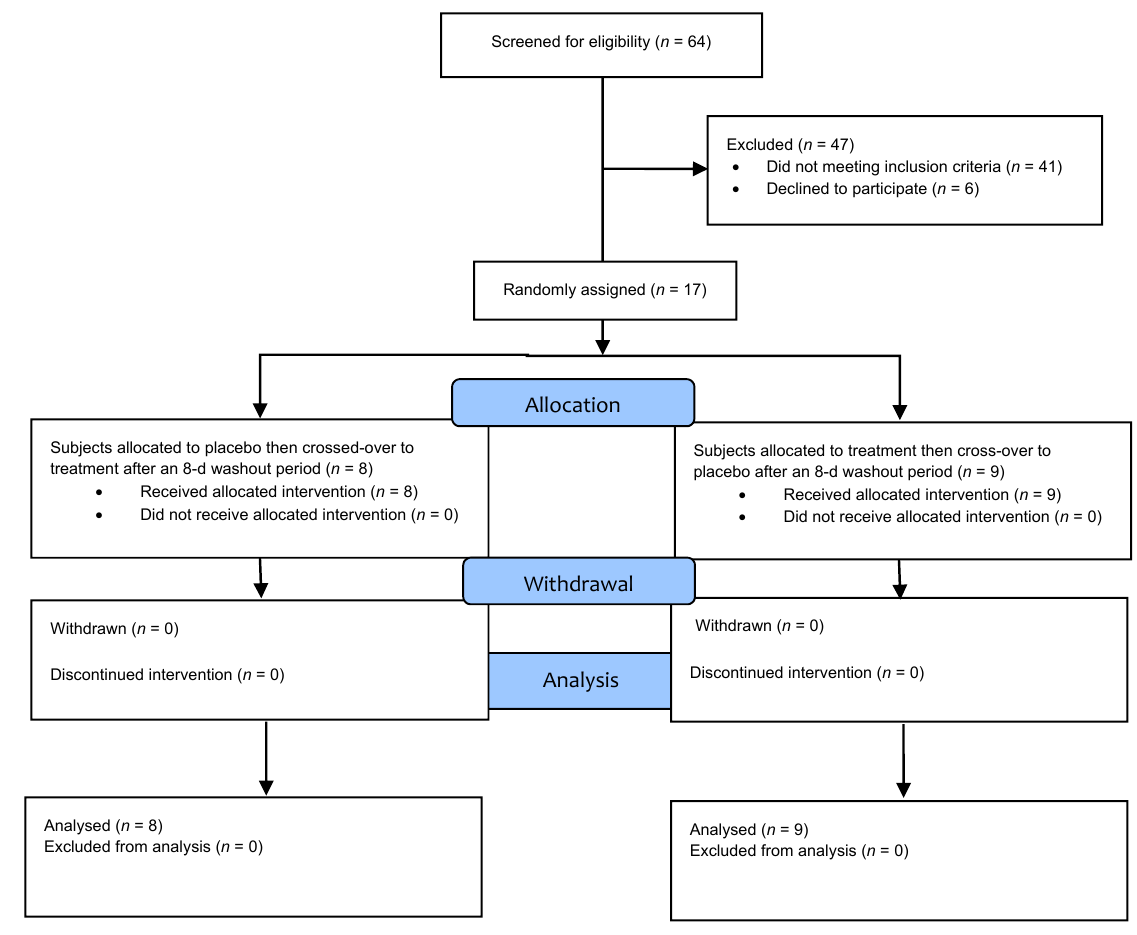
Figure 1. CONSORT diagram for study trial. CONSORT, Consolidated Standards of Reporting Trials. Table 2. Characteristics of study participants at baseline 1